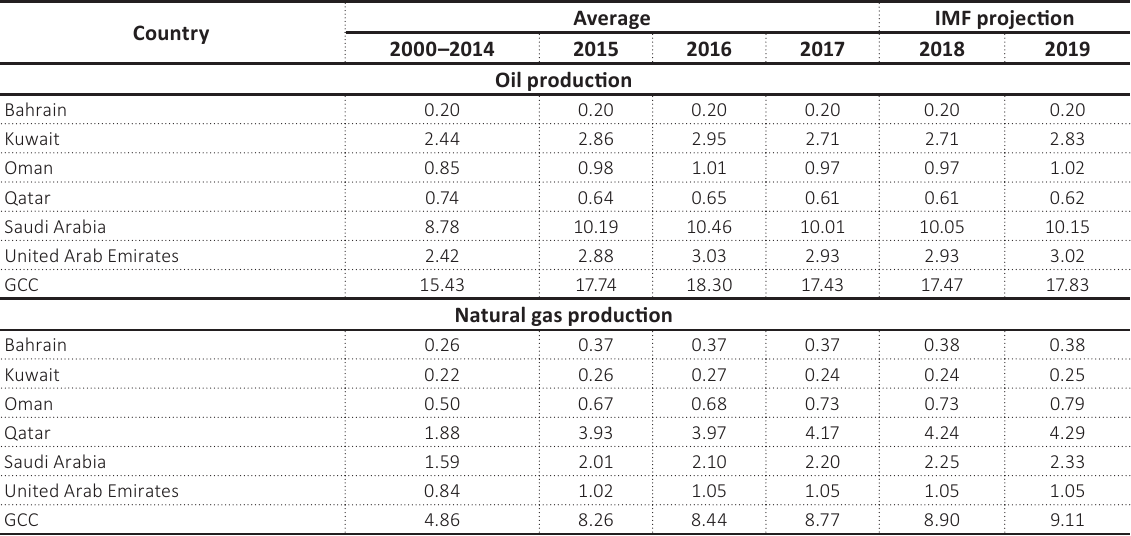
Table 5. Consumer price inflation (average year, %) Country